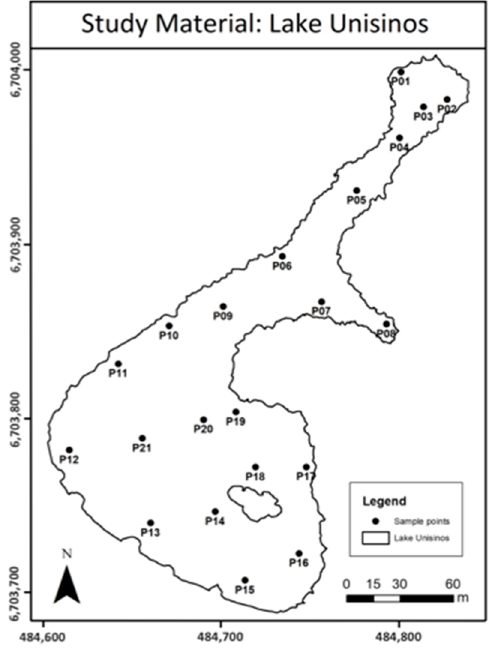
Figure 3. Positions of the sampling points.